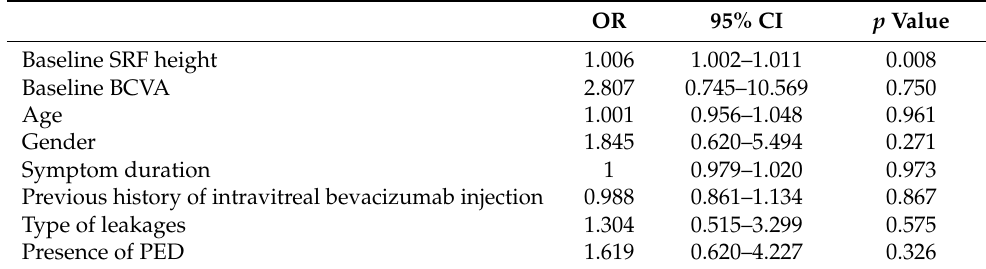
Table 6. Multiple logistic regression analysis of factors associated with need for SRT retreatment in patients with chronic central serous chorioretinopathy.